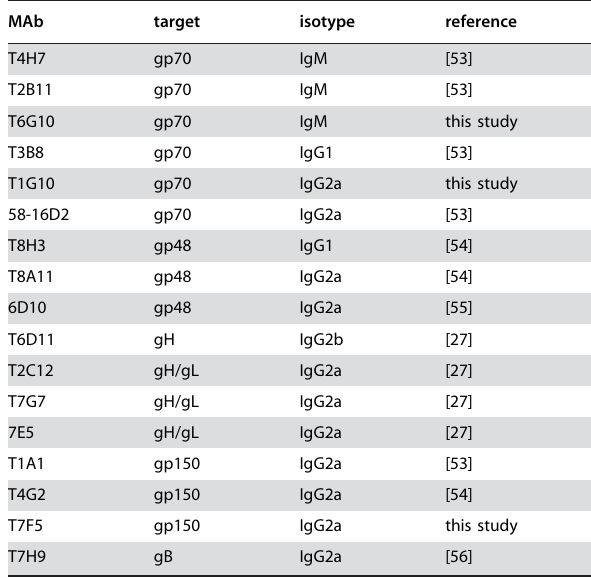
Table 1. MHV-68 glycoprotein-specific mAbs used in this